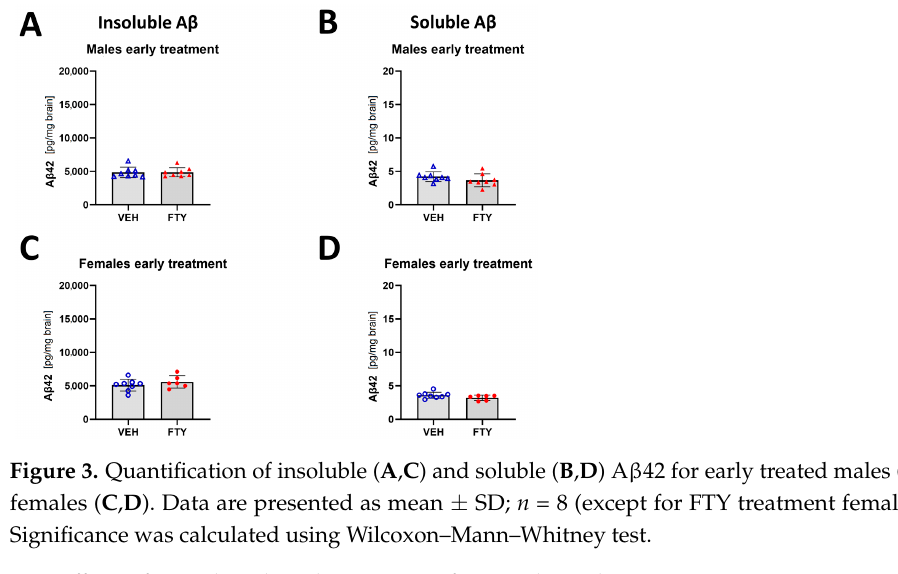
Figure 2. Quantification of insoluble ( A , C ) and soluble ( B , D ) A β 42 for late treated males ( A , B ) and females ( C , D ) APPtg mice. Data are presented as mean ± SD; n = 8 (except for males VEH, n = 13; FTY, n = 12). Significance was calculated using Wilcoxon–Mann–Whitney test, and it is given as *: p ≤ 0.05, **: p ≤ 0.01.